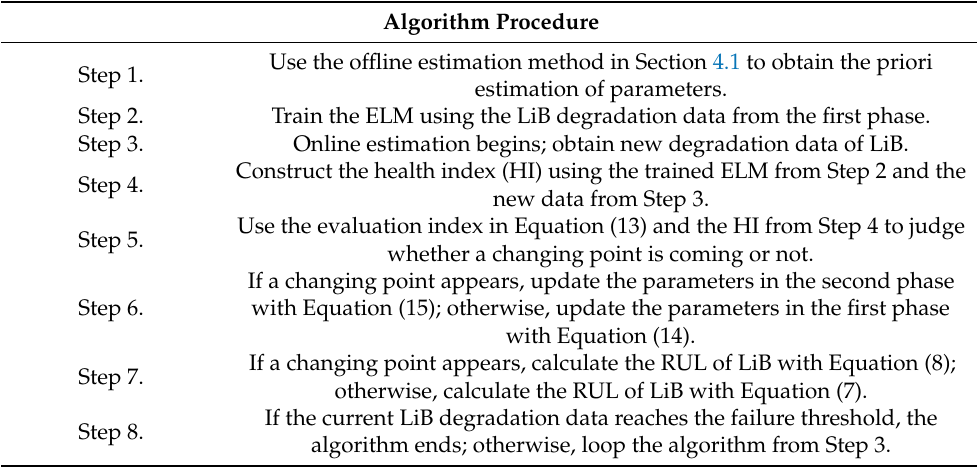
Table 1. Implementation procedures of remaining useful life (RUL) estimation for LiB.